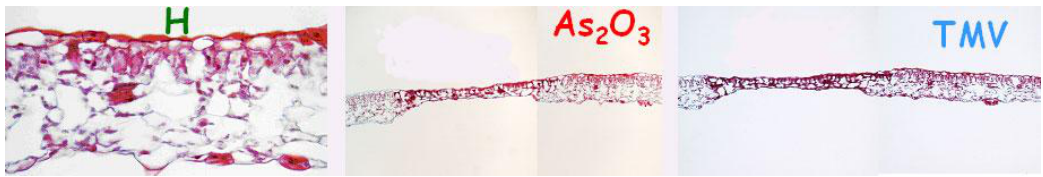
FIGURE 7. Cross-sections of tobacco leaves; H = healthy leaf, As TMV = leaf inoculated with